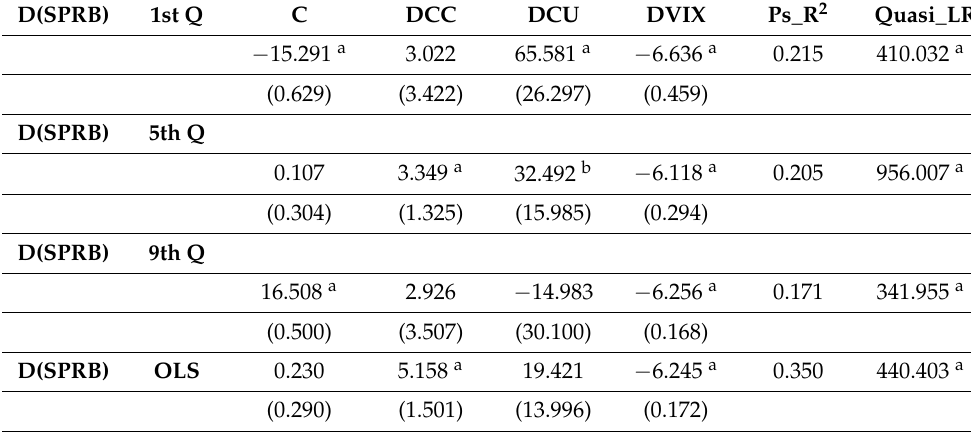
Table 3. Quantile regression estimation of Equation